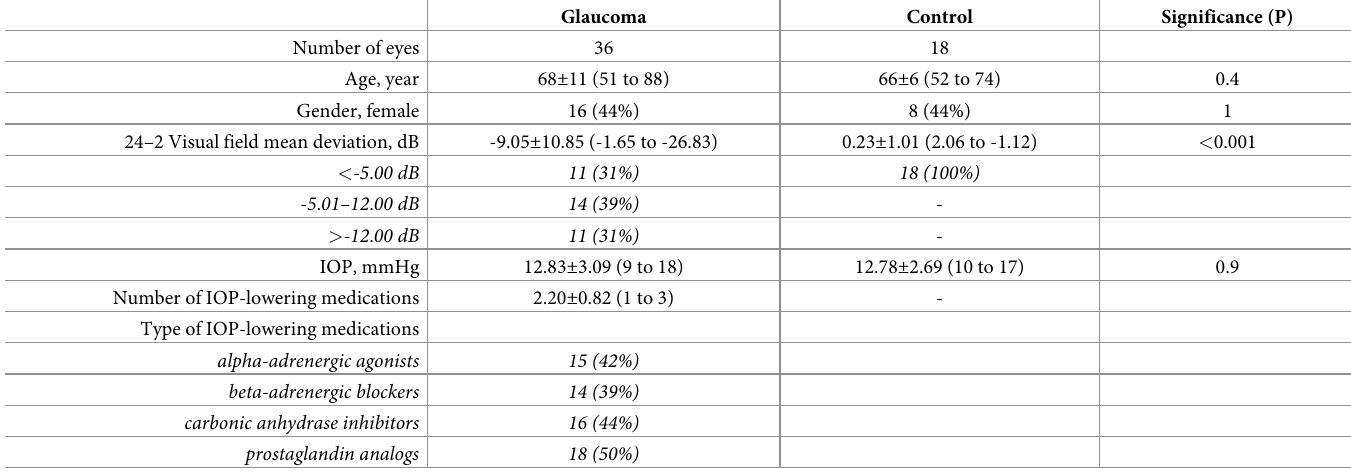
Table 1. Demographic features and clinical characteristics of the study groups.